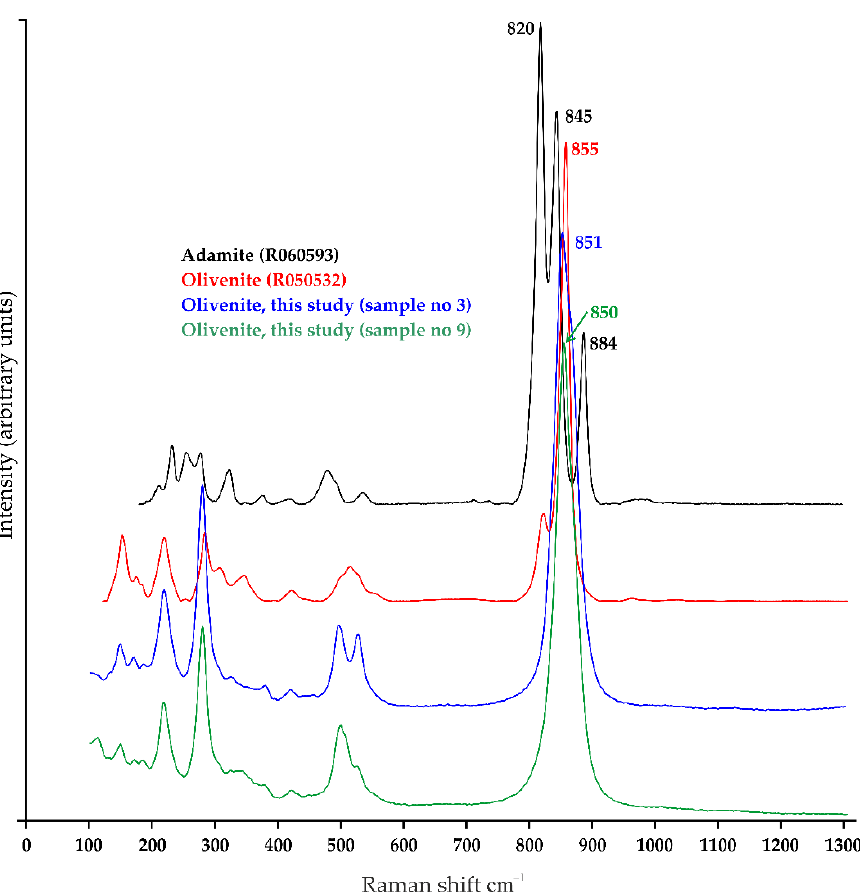
Figure 8. Reference spectra of olivenite and adamite, with the spectra measured in samples 3 and 9.